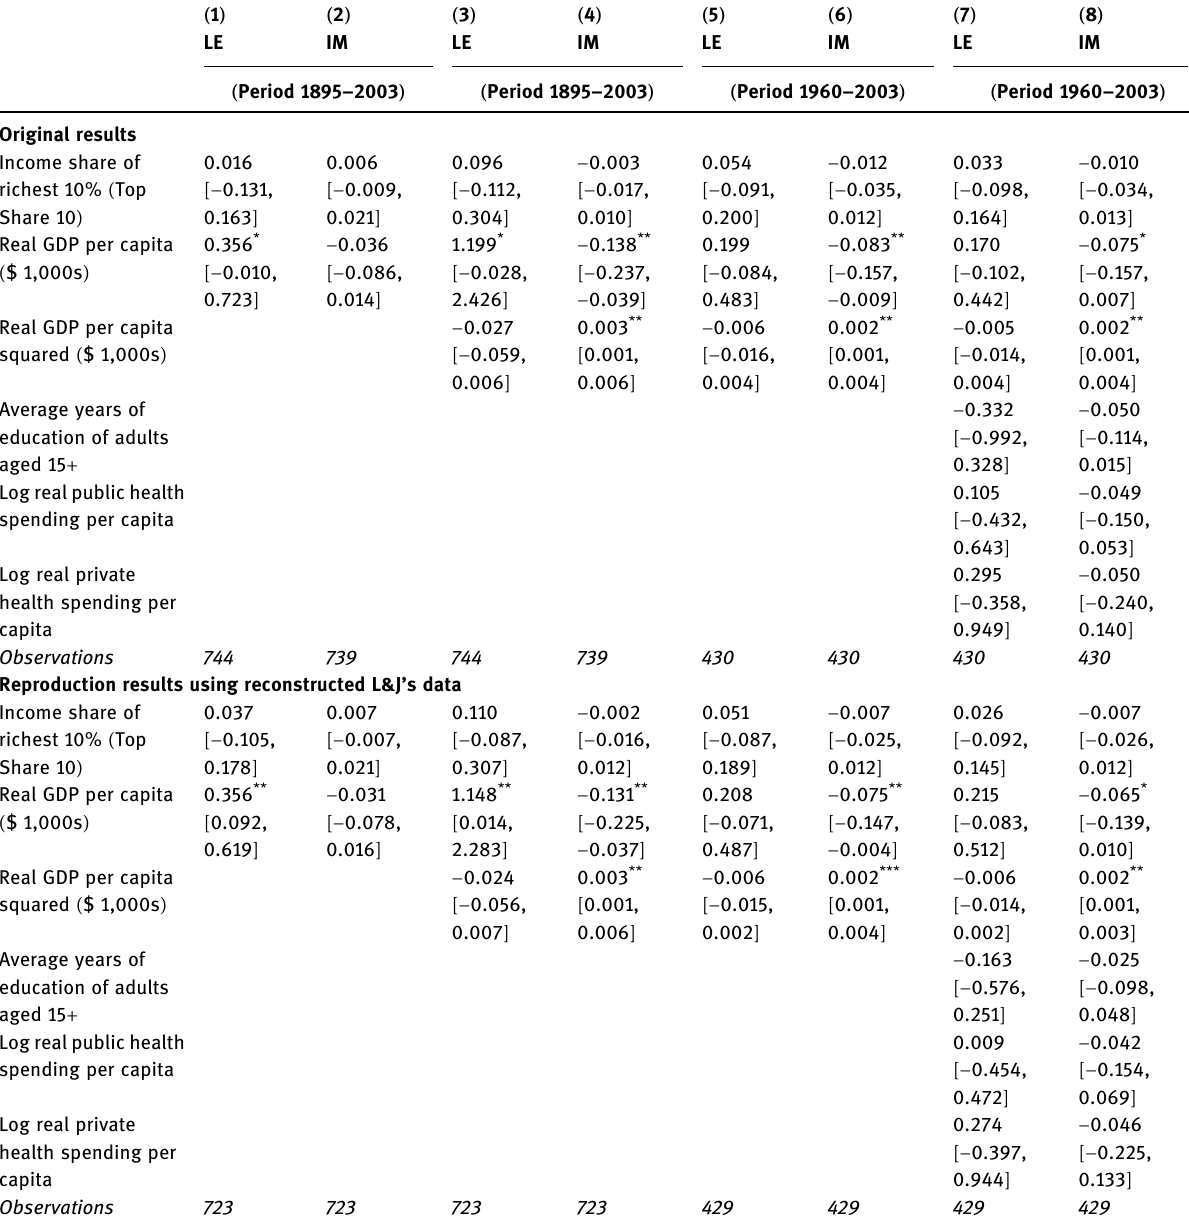
Table 1: Comparison of two - way fi xed - e ff ect estimates in L&J ’ s Table 4 with reproduction